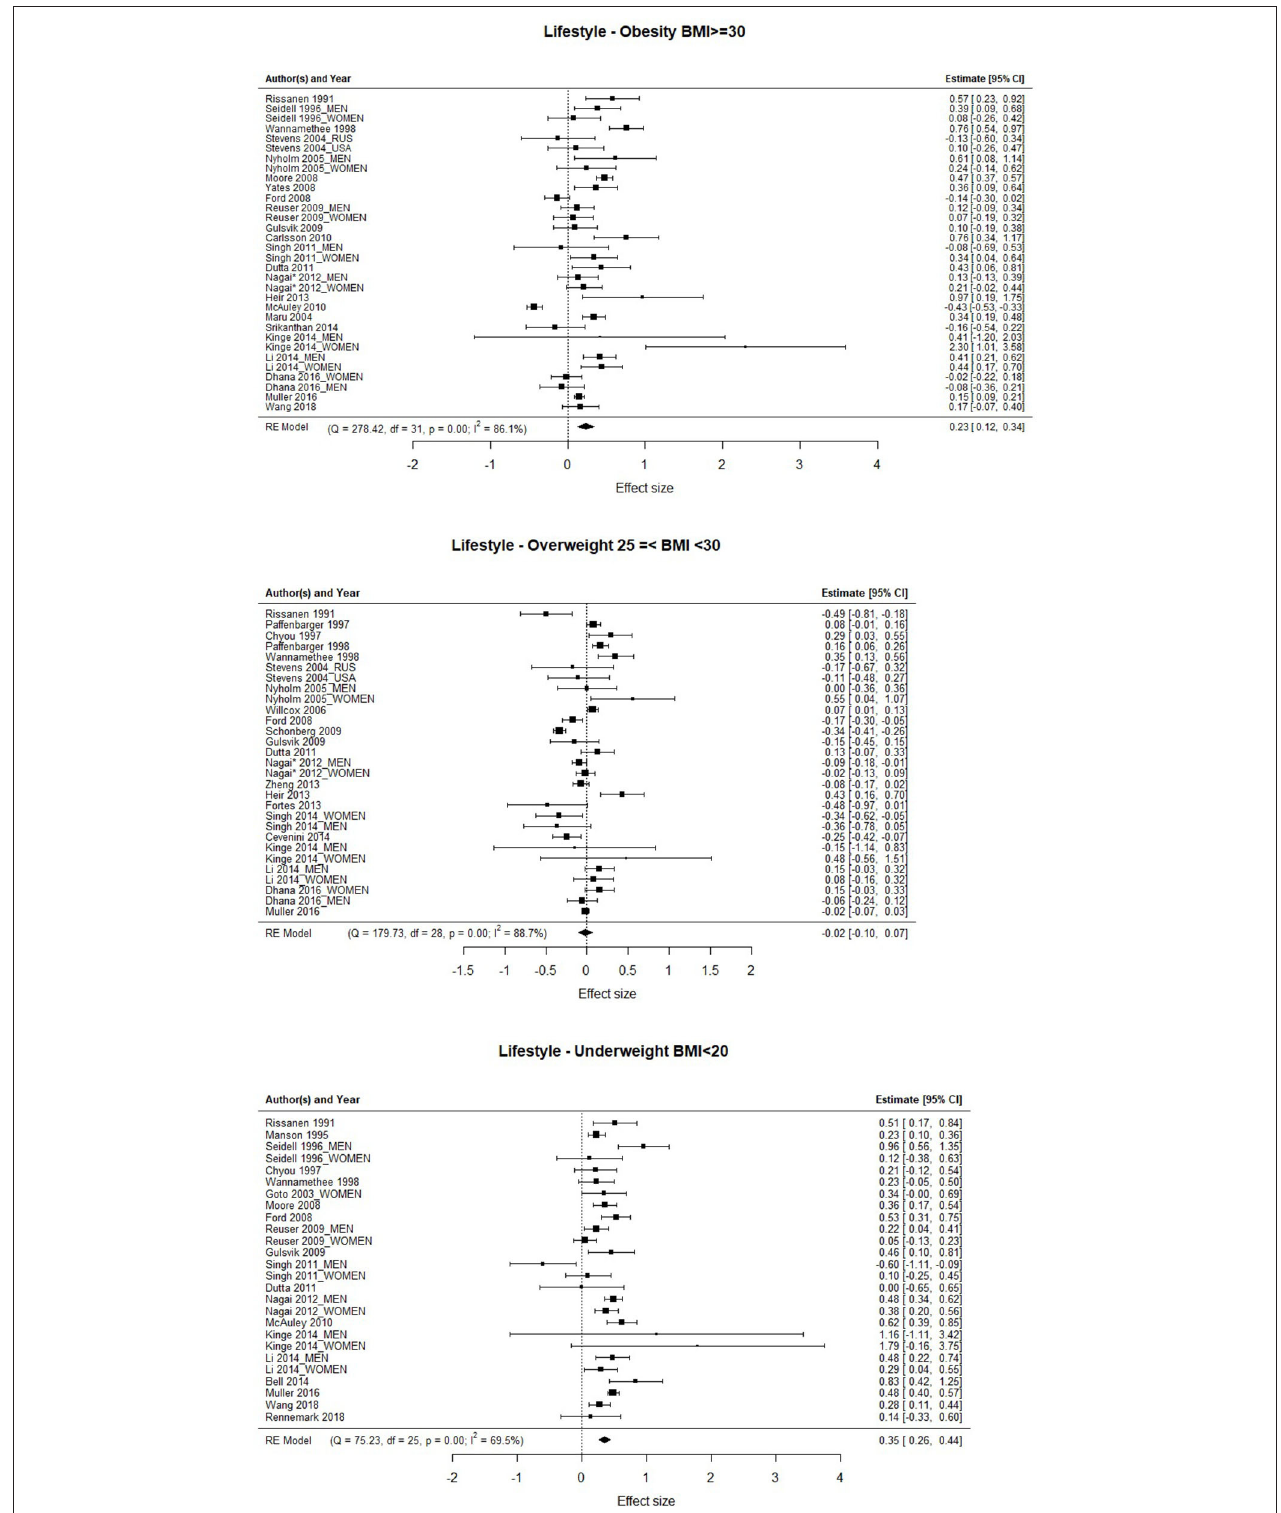
FIGURE 6 | Association between obesity, overweight, and the risk of mortality.